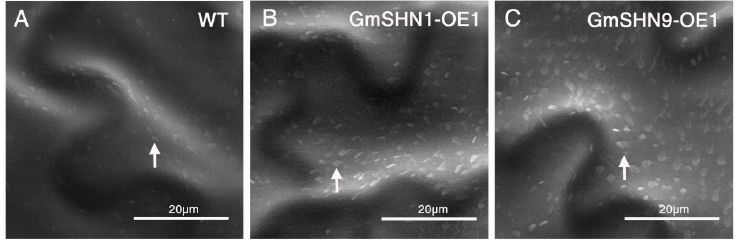
Figure 7. Environmental scanning electron microscopy (ESEM) analysis of leaf cuticle wax depositions. Adaxial side of 4-week-old Arabidopsis rosette leaves of WT, GmSHN1-OE1, and GmSHN9-OE1 were observed under 4000× magnification. ( A ) WT showed only little wax deposition on Leaf surface. The leaf surfaces of transgenic plants GmSHN1-OE1 ( B ); and GmSHN9-OE1 ( C ) are regions of high wax deposition. Wax crystals were shown by arrows.